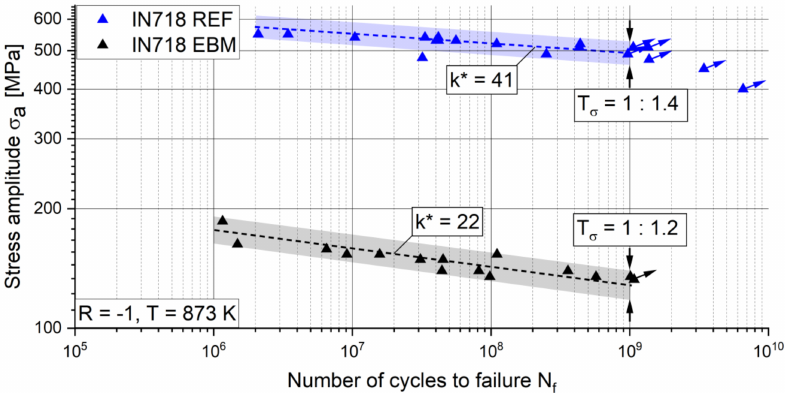
Figure 5. SN-curves of IN718 (black: EBM material, blue: REF material) including runouts (marked by arrows). The slope parameter k * and the scatter T σ were tested at a temperature of 873